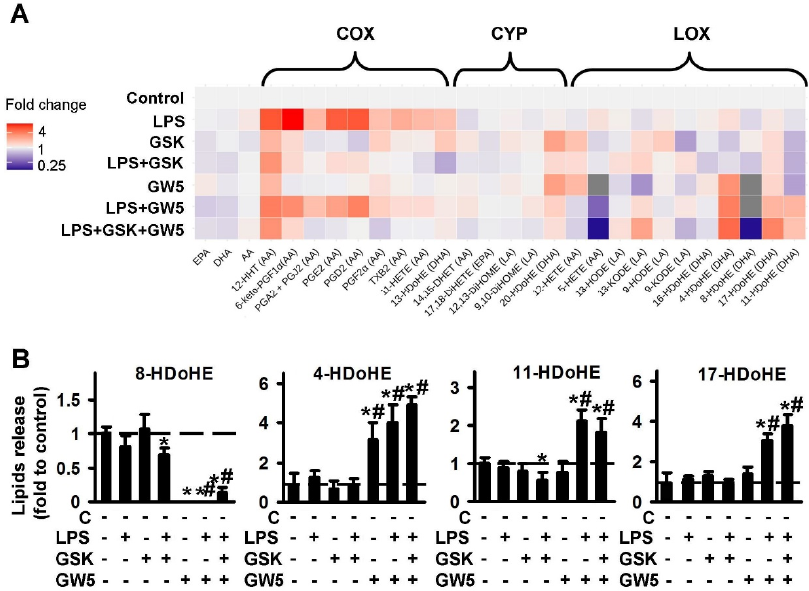
Figure 2. Effect of PPARβ agonist GW501516 and antagonist GSK0660 on the oxylipins release in the LPS-stimulated astrocytes. Primary rat astrocytes were pretreated for 30 min with GSK0660 (GSK, 5 μM) or GW501516 (GW5, 25 μM) or in combination, and then stimulated with LPS (100 ng/mL) for 4 h. Concentrations of oxylipins in supernatants were measured using UPLC-MS/MS. ( A ) The heat map shows relative amounts of each lipid mediator compared to the control. The vertical axis indicates the stimuli, while the horizontal axis indicates the relative amount (log2) of each lipid mediator. Metabolites were divided into: Lipoxygenase (LOX), cyclooxygenase (COX), and cytochrome (CYP) pathways involved in their synthesis. ( B ) The bars show relative amounts of COX-derived lipid mediators. Values represent the mean ± SEM from three independent experiments. * p < 0.05, compared with the unstimulated cells, # p < 0.05, compared with the LPS-stimulated cells.